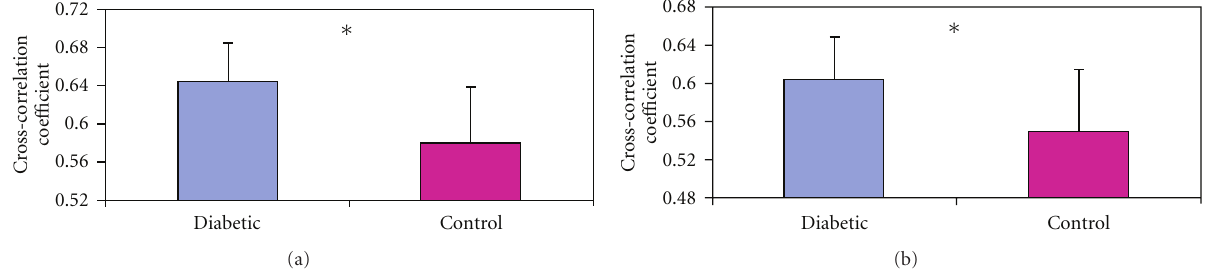
Figure 7: Bar charts showing average overall cross-correlation coe ffi cients of blood pressure and heart rate in diabetes-prone (BBDP) and diabetes-resistant (BBDR) control rats. These are aggregate results averaged over 9 months. (a) shows the average peak Xcorr while (b) shows the average nadir Xcorr values. Values are means ± SEM. ( n = 8 in each group). ∗ P < .